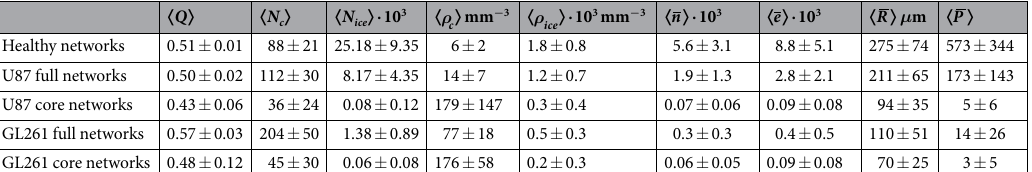
Table 3. Structural properties of communities uncovered in the vascular networks. Mean values with SD among samples are given for the final partitioning modularity Q , the number of communities per specimen N c , the number of intercommunity edges N ice , the mean number of communities and intercommunity edges per mm 3 (shrunken) tissue volume, ρ and ρ , respectively, the mean number of nodes n and edges e per community, as c ice well as mean physical extent R and perimeter P of the communities within each sample.